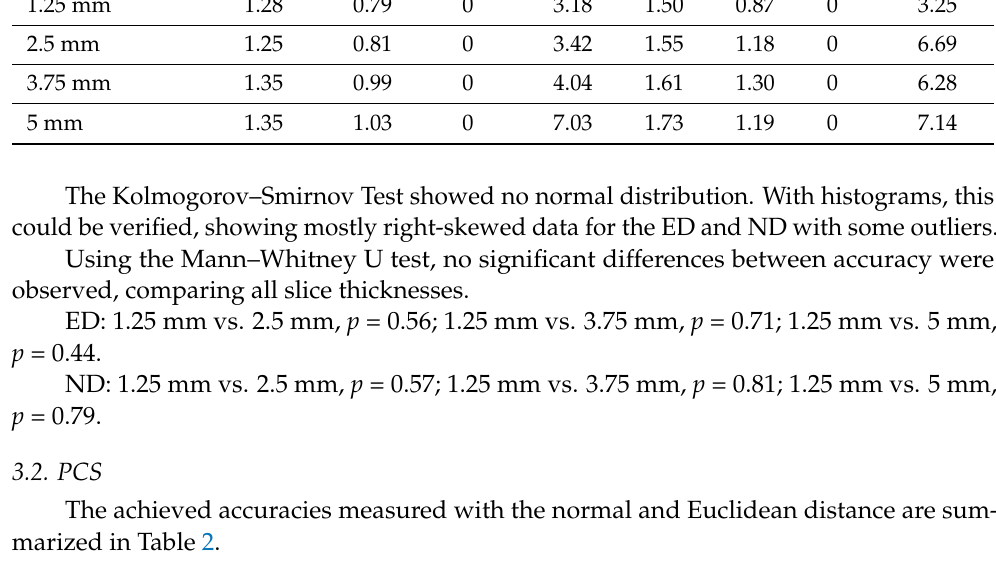
Table 1. Normal distance and euclidean distance under guidance with the Maxio. ND ED Slice Thickness Mean SD Min Max